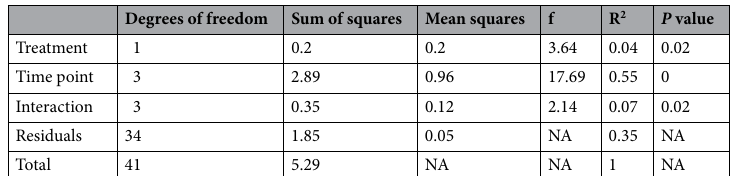
Degrees of freedom Sum of squares Mean squares f R 2 P